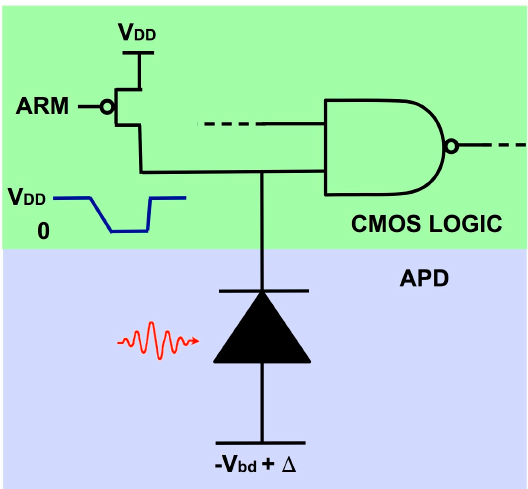
Figure 1. Photon-to-digital conversion. The GMAPD is biased so that it produces a CMOS-logic-compatible voltage pulse, enabling a direct connection to pixel logic.